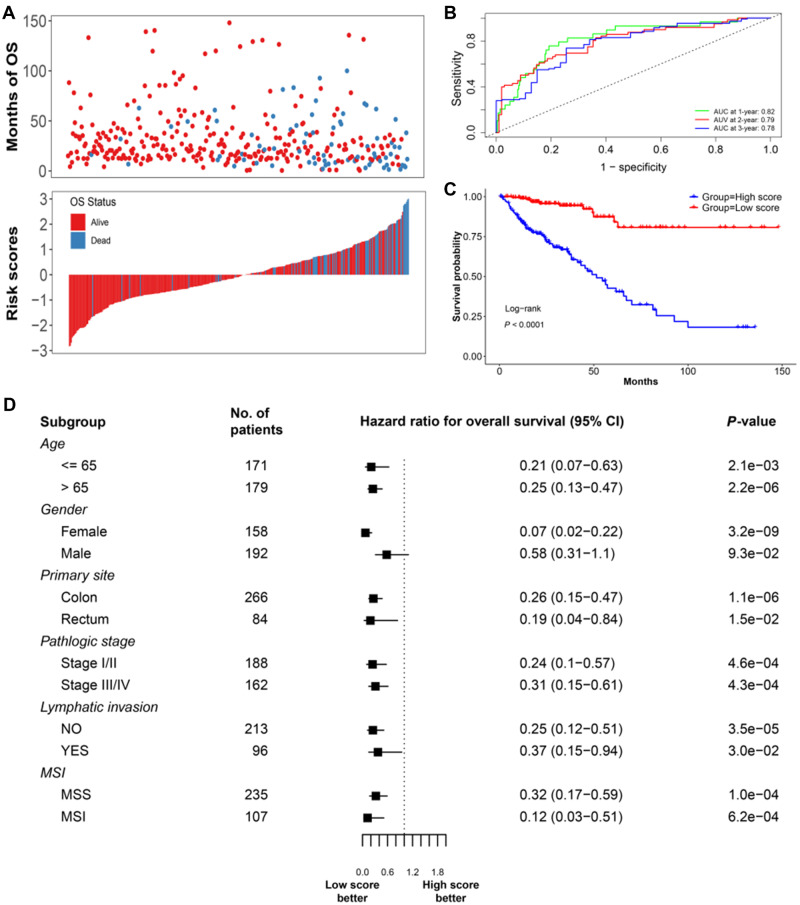
Construction of prognostic signature base on dysregulations with TCGA CRC dataset. (A) Scatter plot for OS time, survival status, and risk score for TCGA CRC samples. (B) Time-dependent ROCs for risk score at 1-, 3-, and 5-year survival. (C) Kaplan–Meier curves of OS between two groups cut by median risk core. P-value was generated from log-rank test. (D) Forest plots of the associations between 4-DysReg risk score and OS in various subgroups. High score: the group with risk score larger than the median; low score: the group with risk score smaller than the median.